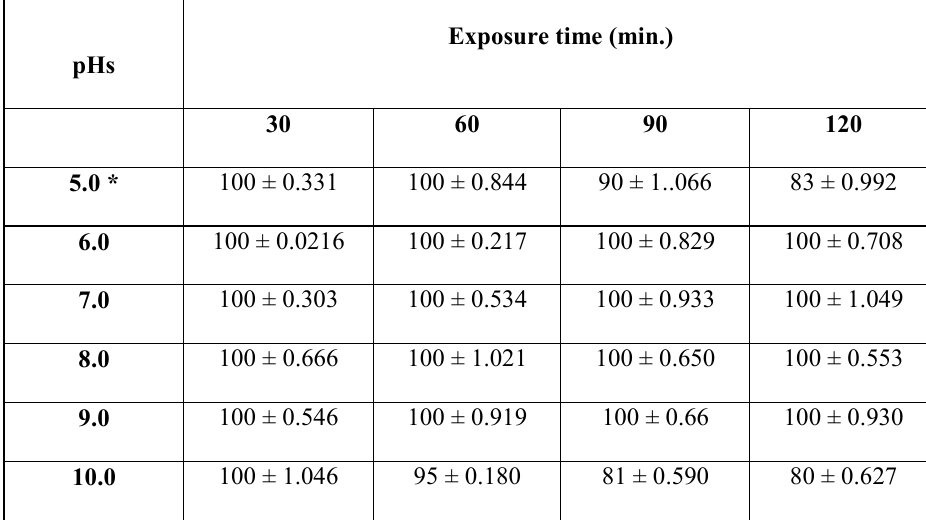
Figure 11. Effect of different NaCl concentrations on partial purified dextranse. Table3. pH stability of the partially purified Bacillus subtilis NRC-B233b dextranase. Relative values of dextranase activity of enzyme, expressed in %, and obtained by Berridge’s method.